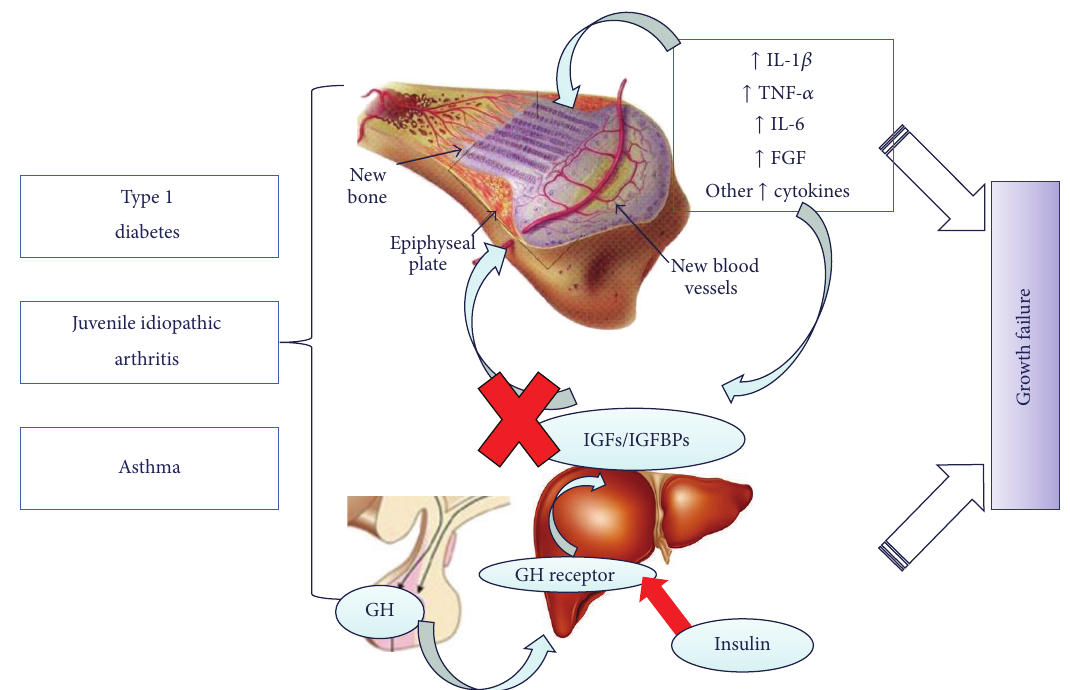
Figure 1: Common factors contributing to growth failure in children and adolescents with type 1 diabetes, juvenile idiopathic arthritis and asthma. GH: growth factor; IGFs: insulin-like growth factors; IGFBPs: insulin-like growth factor binding proteins; IL-1 𝛽 : interleukin-1 𝛽 ; TNF- 𝛼 : tumor necrosis factor- 𝛼 ; IL-6: interleukin-6; FGF: fibroblast growth